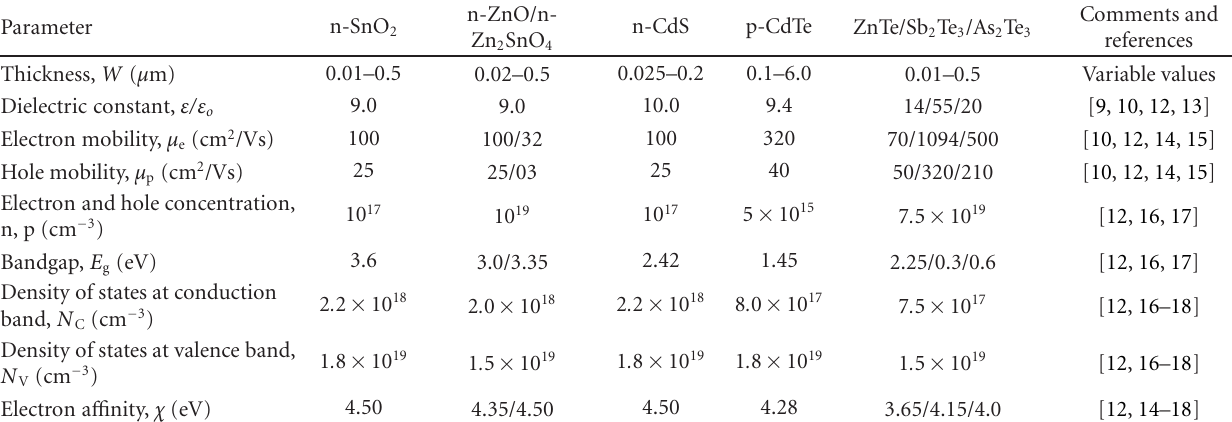
Table 1: Material parameters used in